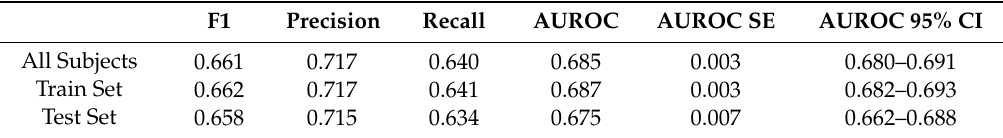
Table 6. The evaluation metrics of the artificial neural network classification model for mortality. Figure 4. Presents the receiver operating curve (ROC) of the evaluation metrics of the random forest classification model.